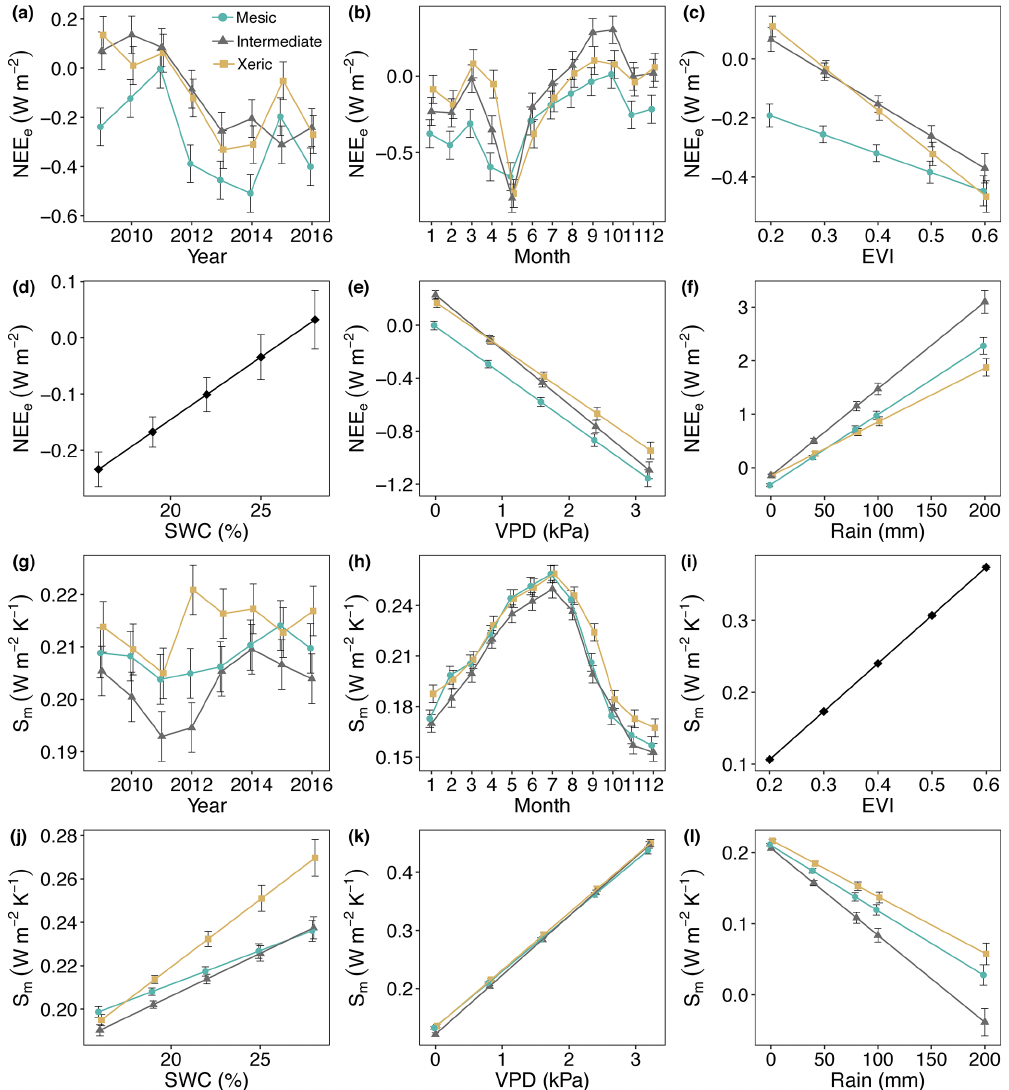
Figure 7. Least squares mean predictive values from mixed model of (a–f) the metabolic energy flux (NEE e ) and (g, l) metabolic entropy fluxes of ( S m ) by site and (a, g) year, (b, h) month, (c, i) enhanced vegetation index (EVI), (d, j) soil water content (SWC), (e, k) vapor pressure deficit (VPD) and (f, l) rain. For (d) and (i) the interaction with site was not significant, as indicated by a single solid black line. Error bars represent